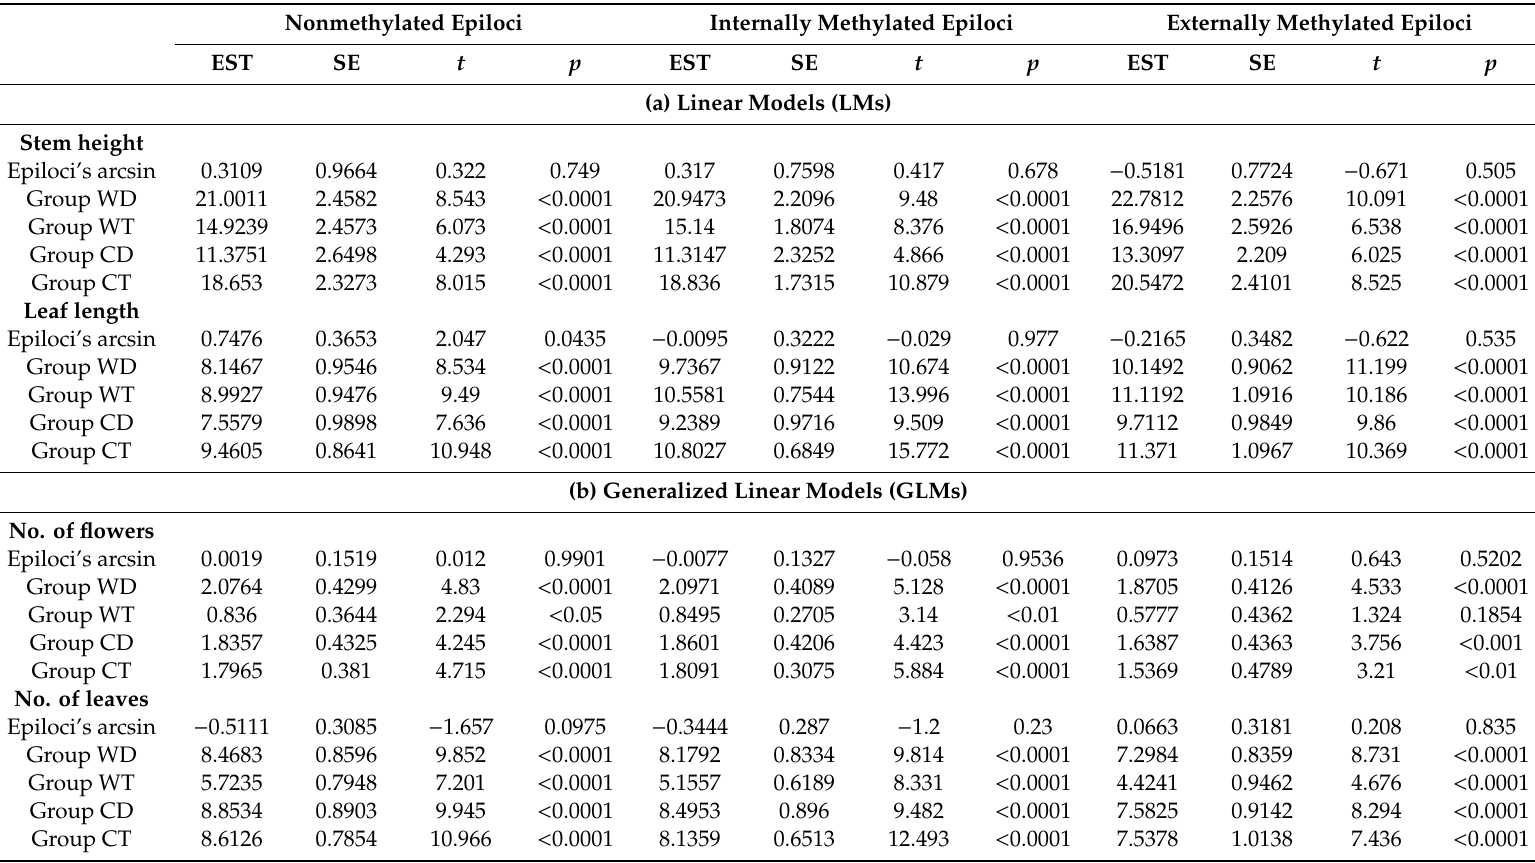
Table 2. Linear model and generalized linear model results, investigating the relationship of morphological traits with DNA methylation (MS-AFLP) patterns and predefined groups. MS-AFLP patterns are reported separately for di ff erent types of epiloci [70]: ( a ) linear models (model p -values < 0.0001); ( b ) generalized linear